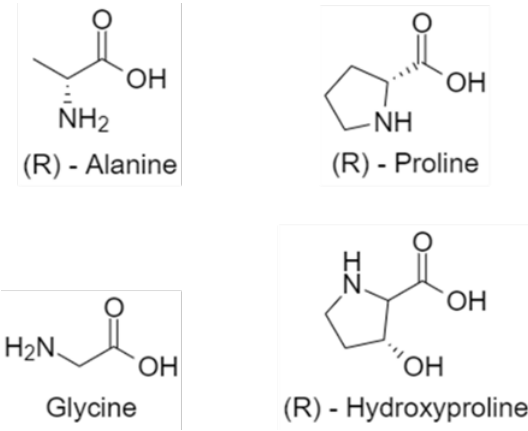
Figure 1. Collagen triple helix.